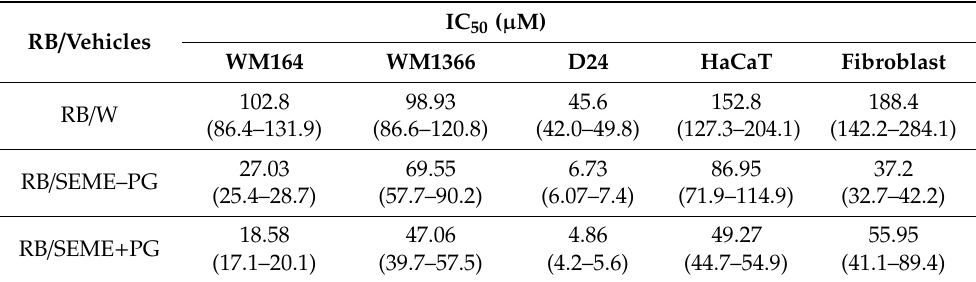
Figure 4. Dose-dependent response of RB and encapsulated RB. Cellular response to the treatment with RB and encapsulated RB after 48 h of incubation observed in ( A ) WM164; ( B ) WM1366; and ( C ) HaCaT cell lines. Average cell viability ± SD plotted ( n = minimum of 4). Table 3. IC 50 values of RB and encapsulated RB on WM164, WM1366, D24, and HaCaT cell lines after 48 h of incubation. All values are expressed in mean concentration of RB ( µ M) with 95% confidence interval indicated in brackets ( n = minimum of